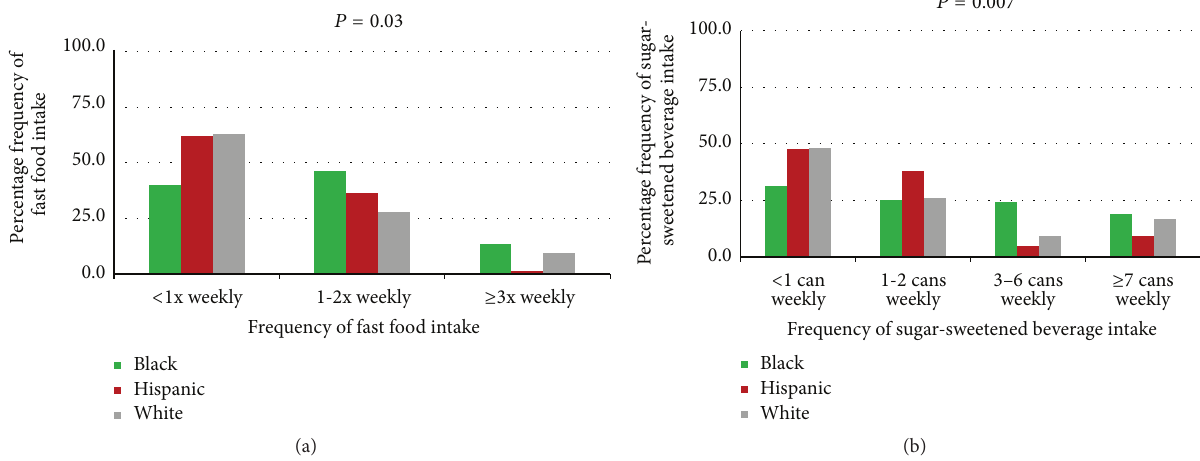
Figure 1: (a) Unadjusted weekly fast food intake by race/ethnicity. (b) Unadjusted weekly sugar-sweetened beverage intake by race/ethnicity.